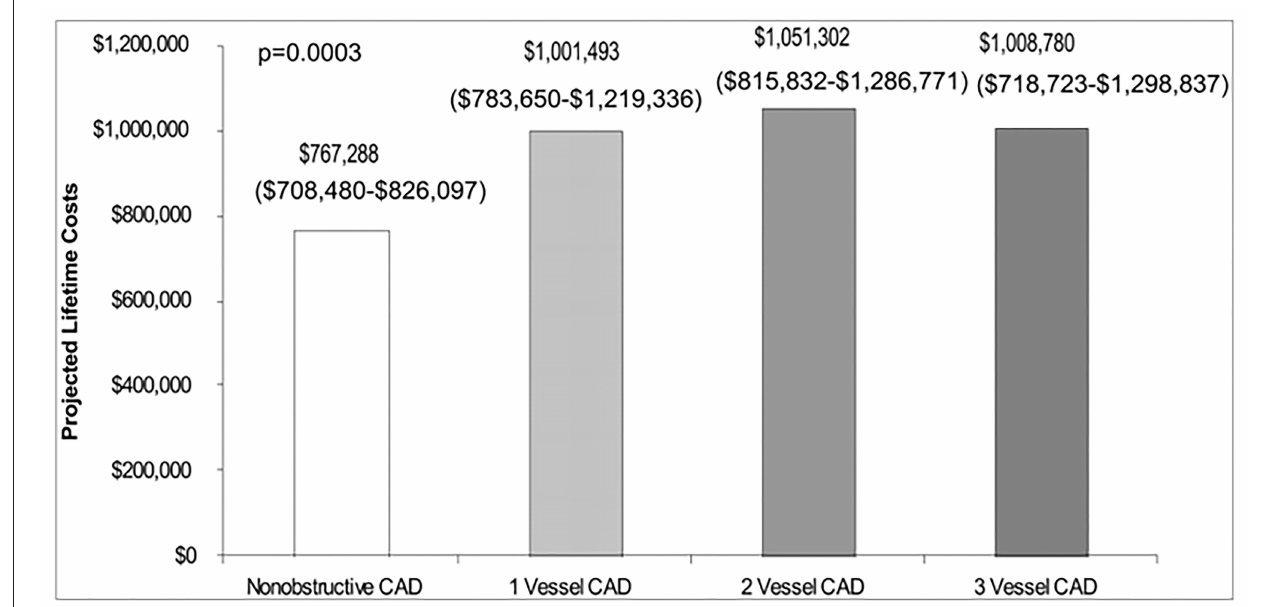
FIGURE 5 | The economic burden of angina in women with suspected ischemic heart disease. Estimated lifetime costs (including sensitivity analyses ranges) of pharmacologic therapy and hospitalization for cardiovascular disease in women with non-obstructive and 1-vessel to 3-vessel CAD. Reprinted with permission (103).